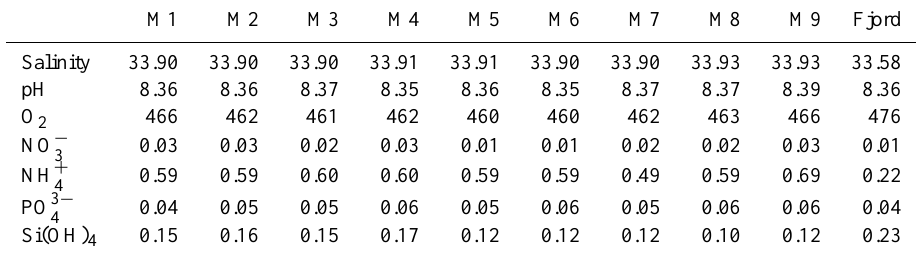
Table 1. Starting conditions in the nine mesocosms (M1-M9) and the surrounding fjord water. Data for salinity, pH and oxygen concentration (determined in situ with a CTD equipped with pH and oxygen sensors) for day t-4, all others for day t0. pH is in total scale, concentrations for oxygen, nitrate, ammonium, phosphate and silicate are in µmolL − 1 . See Schulz et al. (2013) for details on the methodologies. M1 M2 M3